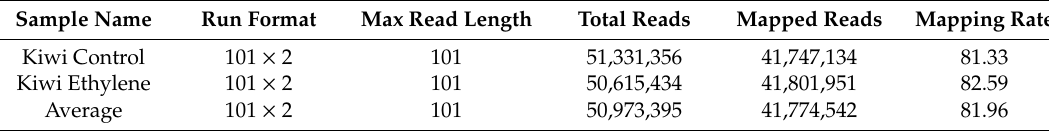
Table 1. Summary of mapping result.